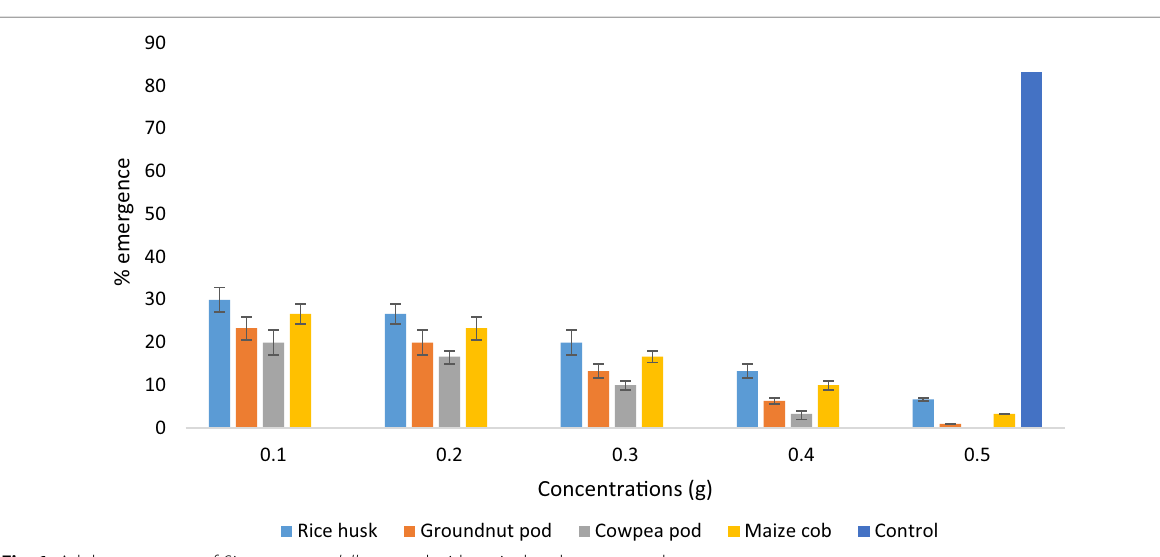
Fig. 1 Adult emergence of Sitotroga cerealella treated with agricultural waste